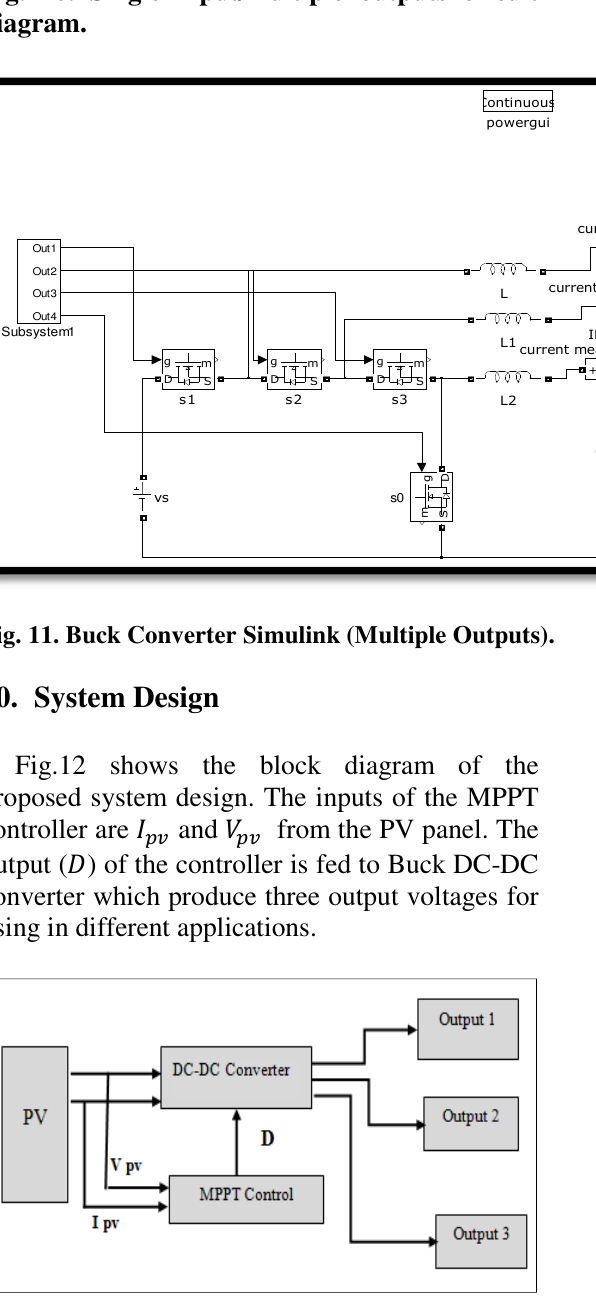
Fig. 12. Proposed system design